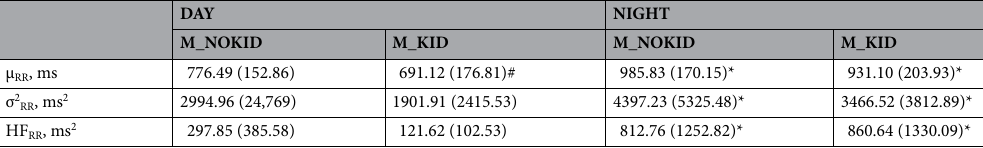
Table 2. Results of the cardiac autonomic profile comparison in M_NOKID and M_KID during DAY and NIGHT. M_NOKID, men without children in preschool age; M_KID, men with children in preschool age; DAY, daytime; NIGHT, nighttime; RR, RR interval; μ RR , mean RR; σ 2 RR , variance of RR; HF, high frequency; HF RR , power of RR series in the HF band. Results are presented as median. In bracket the interquartile range, calculated as the difference between the first and the third quartile is presented. * indicates p < 0.05 DAY versus NIGHT, #indicates p < 0.05 M_NOKID versus M_KID.